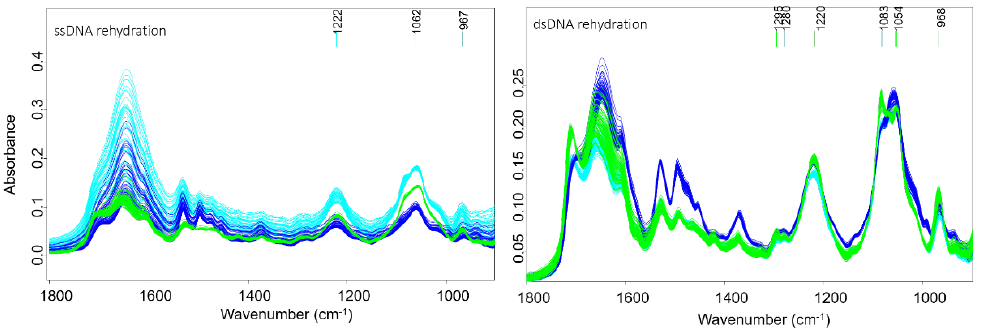
Figure 4. Raw IR spectra of the transition of ss and ds A-DNA to B-DNA upon rehydration. Green: control (DNA treated with acetone), dark blue: DNA treated with PFB, light blue: DNA treated with TMB.